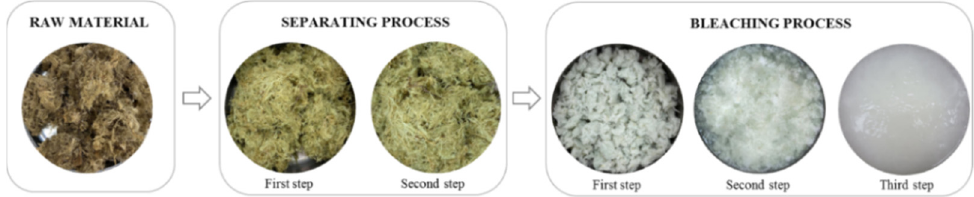
Figure 4. Photographs of the pretreated cellulose.